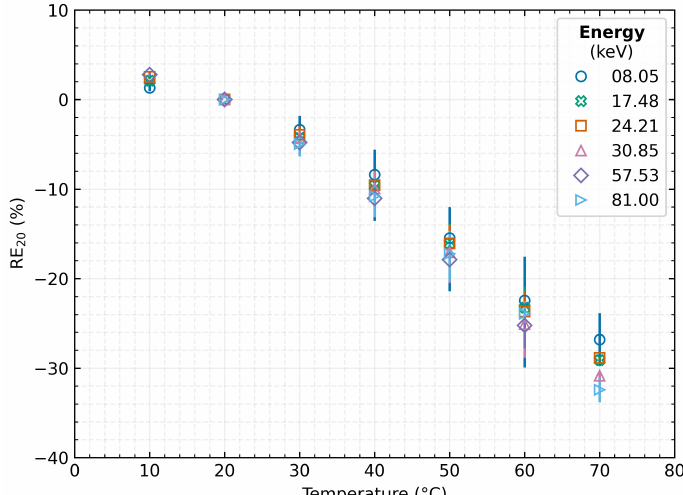
Figure 6. Dependence of the relative measurement error on the detector temperature for different energies of incident radiation. The plotted data represent the mean values over the tested detectors, and the error bars indicate their minimum and maximum